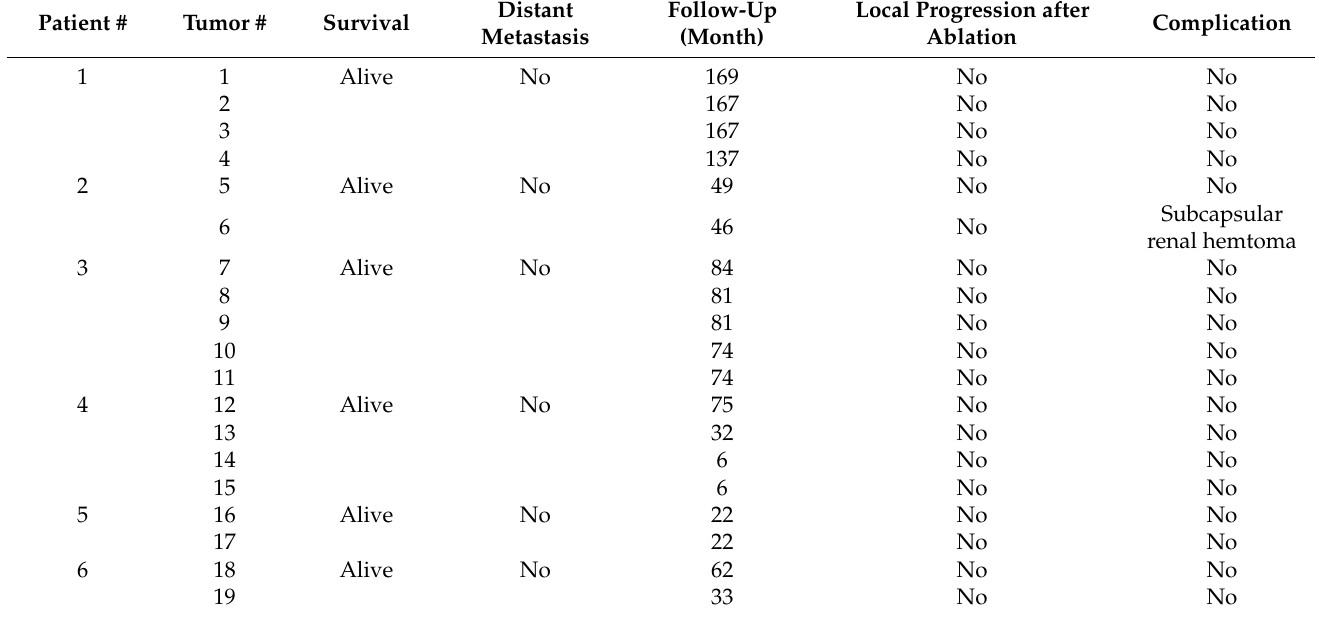
Table 3. Patient outcomes.